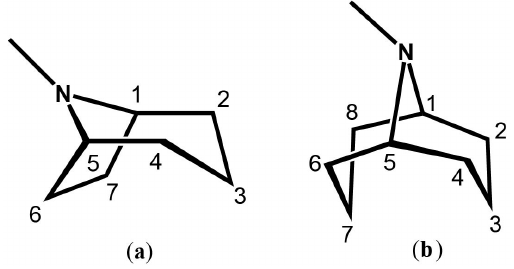
Figure 1. ( a ) The tropane core skeleton; ( b ) The bicyclic granatane core skeleton. Both structures depict their chemically accepted carbon numbering.